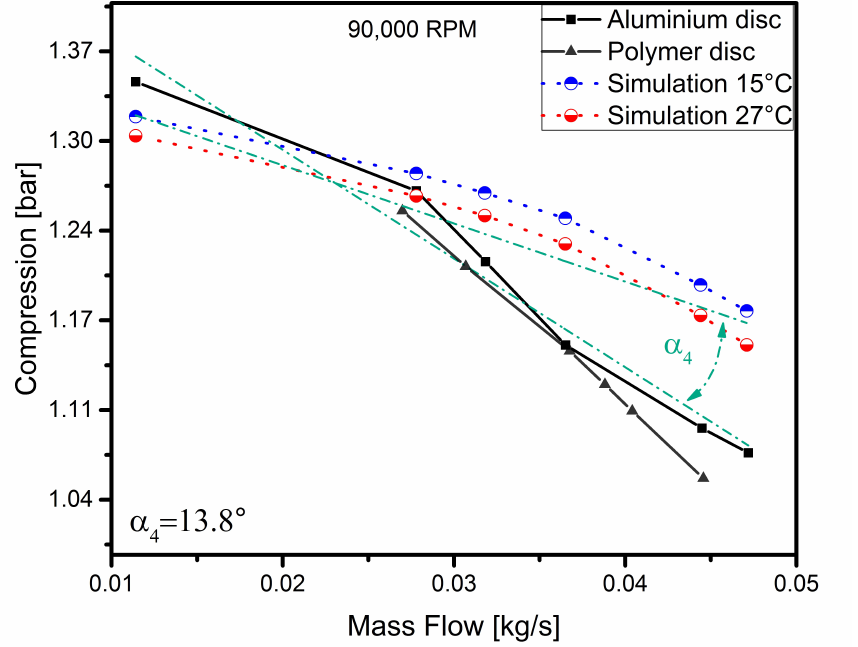
Figure 8. Simulation vs. experimental results for a speed of 90,000